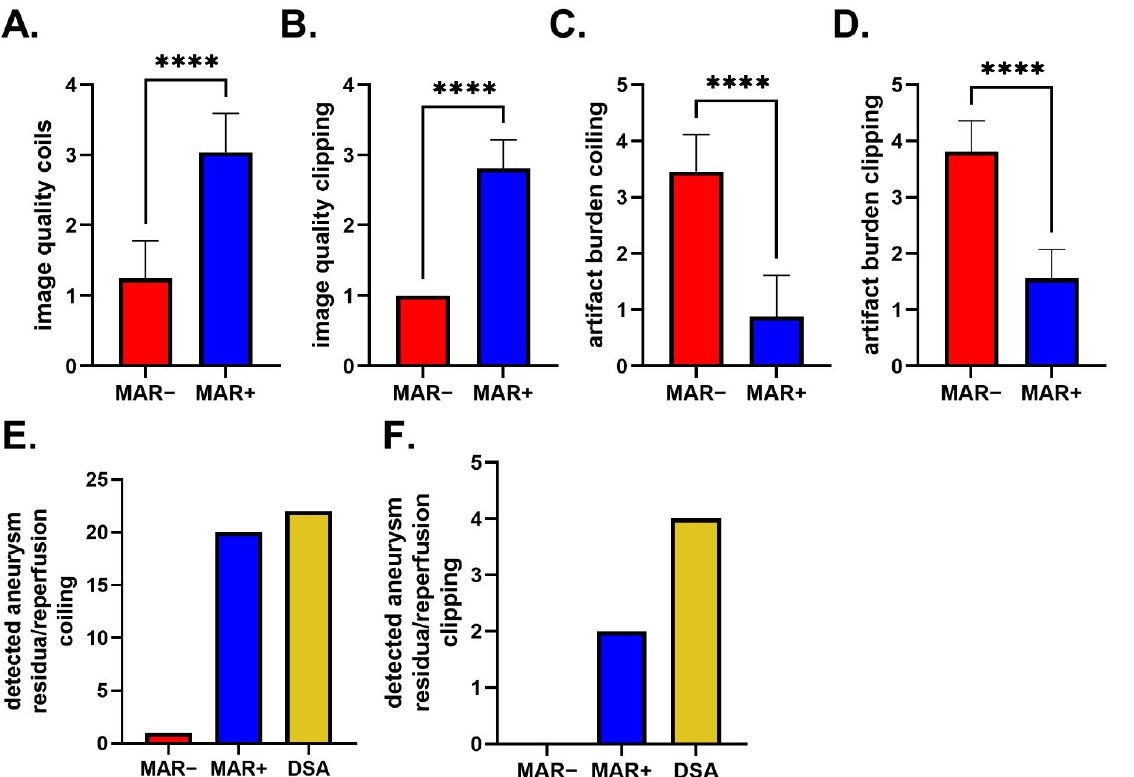
Figure 7. Evaluation of IQ regarding diagnostic value in patients with coiled ( A ) and clipped ( B ) IAs. The iMAR algorithm significantly improves IQ. Evaluation of IQ regarding metal-artifact burden in patients with coiled ( C ) and clipped ( D ) IAs. The iMAR algorithm significantly reduced metal-artifact burden in all cases. ( E ) Number of detected aneurysm reperfusions in patients treated via endovascular coiling. iMAR+ FD-CTA allows better aneurysm reperfusion detection with good agreement with DSA reference in comparison with iMAR − images. ( F ) Number of detected aneurysm residua in patients treated via surgical clipping. iMAR+ FD-CTA allows better aneurysm residua detection in comparison with iMAR − images. p ‐ values less than 0.0001 are marked with “****”.